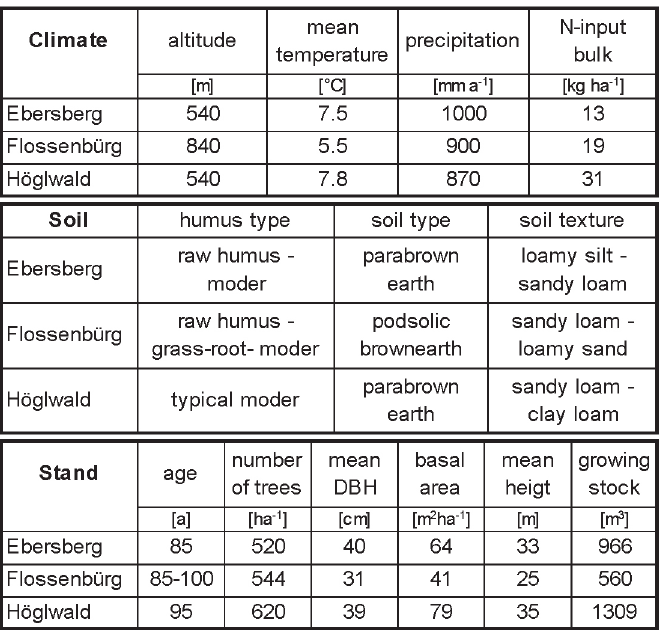
Characteristics of the Three Experimentation Sites: Ebersberg, Flossenbürg, and